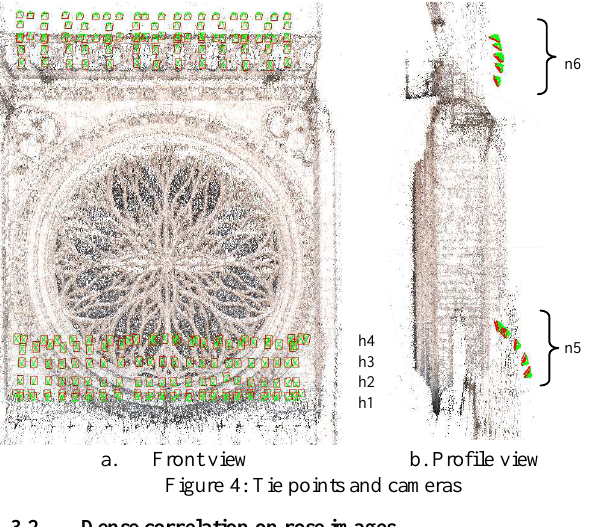
Figure 4: Tie points and